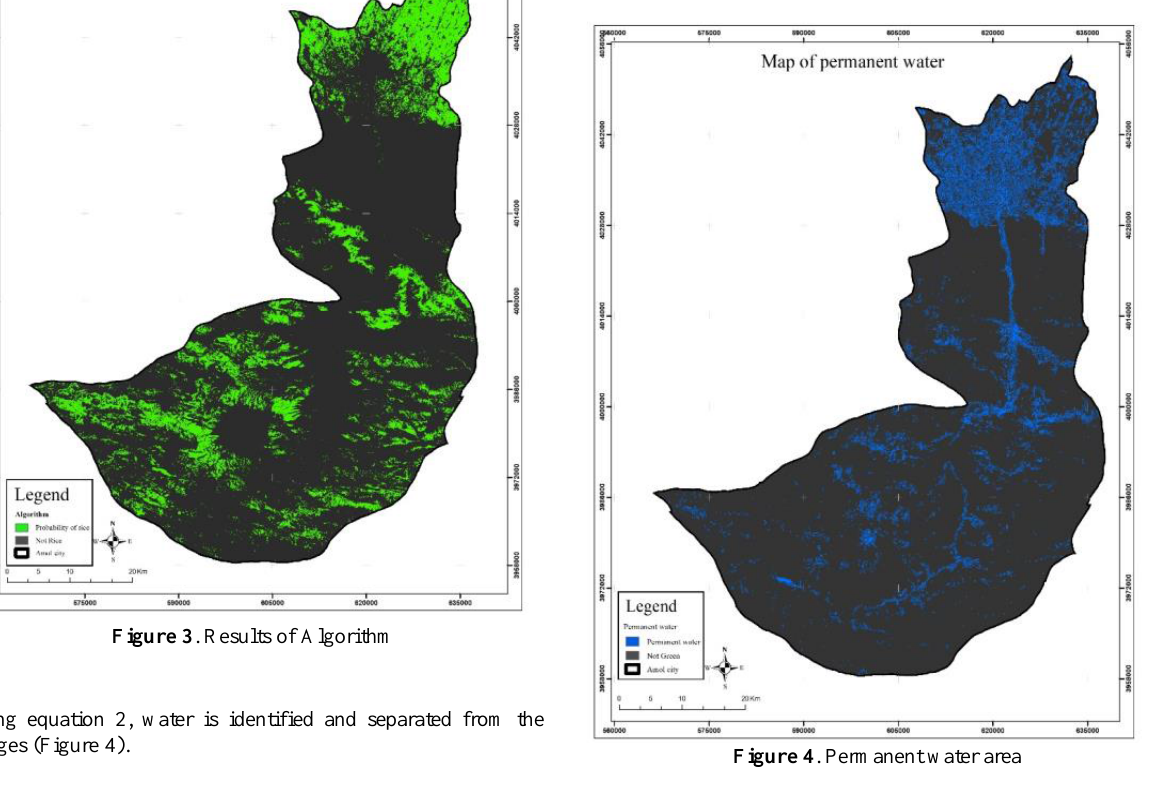
images (Figure 4).